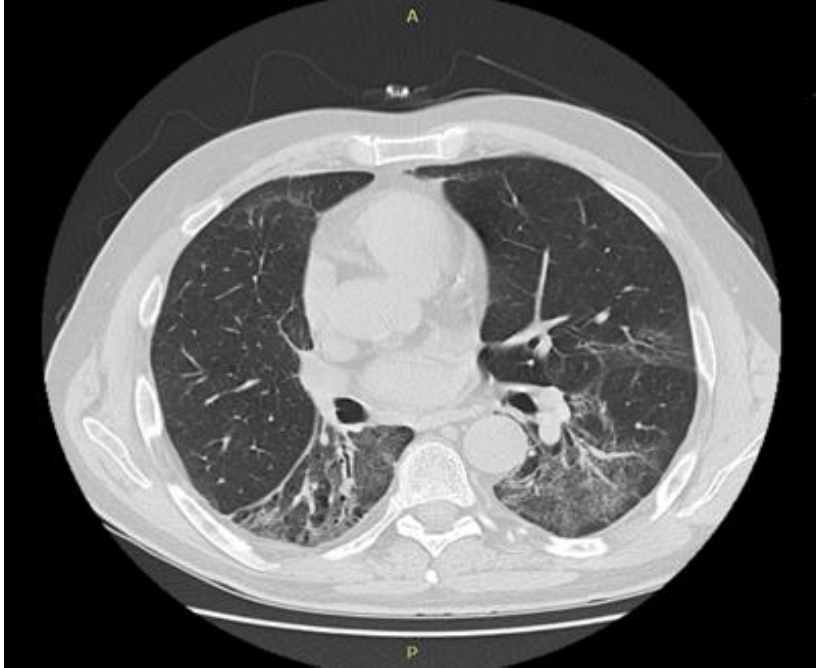
Figure 4. Chest computed tomography scan after 1 month of corticosteroid therapy: partial resolution of the interstitial infiltrates.